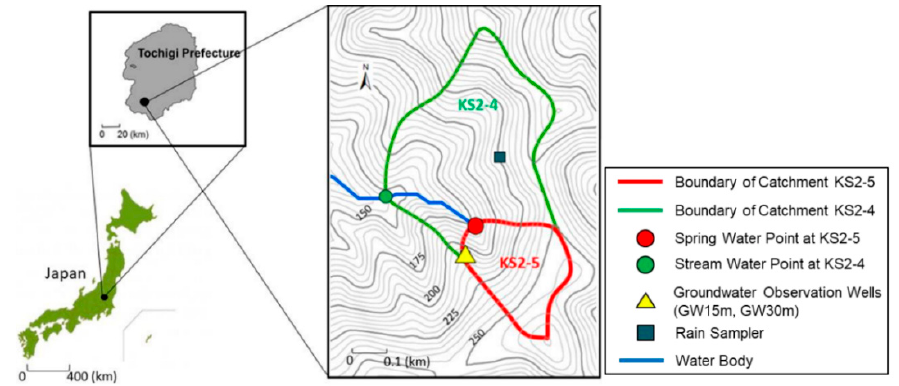
Figure 1. Map of the study area showing the KS2-5 catchment (red boundary) where the spring water and groundwater data were collected, as well as the nearby KS2-4 catchment (green boundary) where precipitation data were